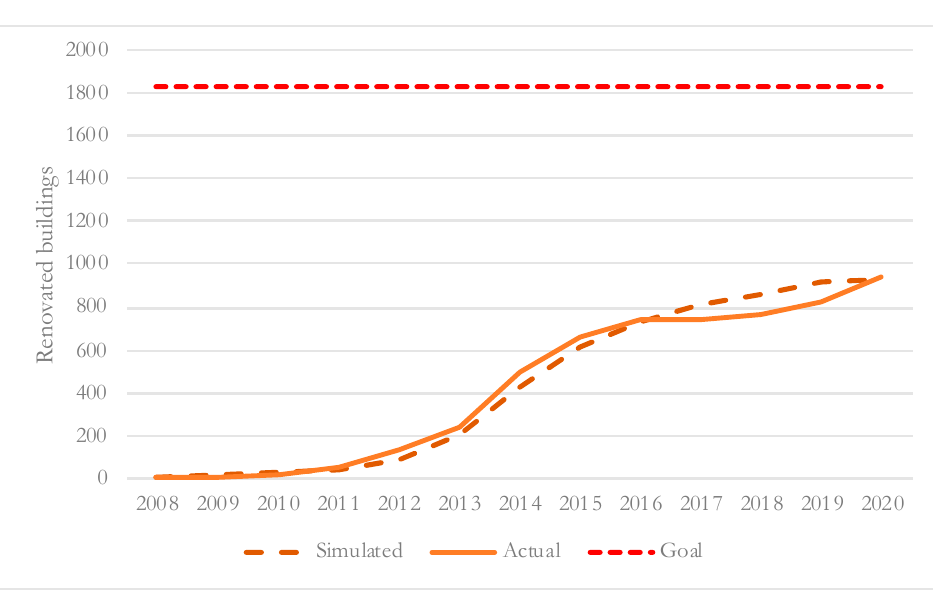
Figure 9. Validation of simulation results with actual data for cumulative number of energy effi- ciency projects in multi-family buildings and national energy efficiency goal for the multi-family building sector.